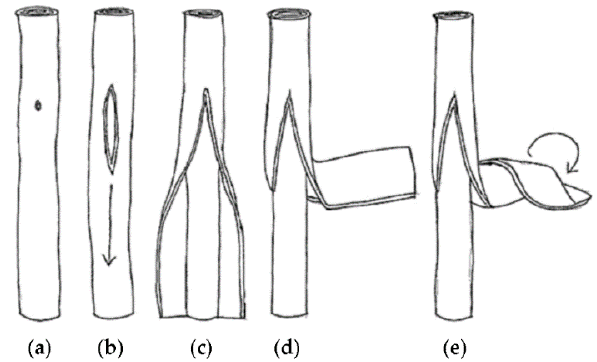
Figure 1. A schematic diagram of the suggested “unzipping” and “re-rolling” sequence: ( a ) formation of unzipping point; ( b ) onset of unzipping; ( c ) unzipping and onset of peeling of inner parallel tubes; ( d ) outer layers peeling out as a sheet; ( e ) onset of re-rolling of outer layers. Reproduced from